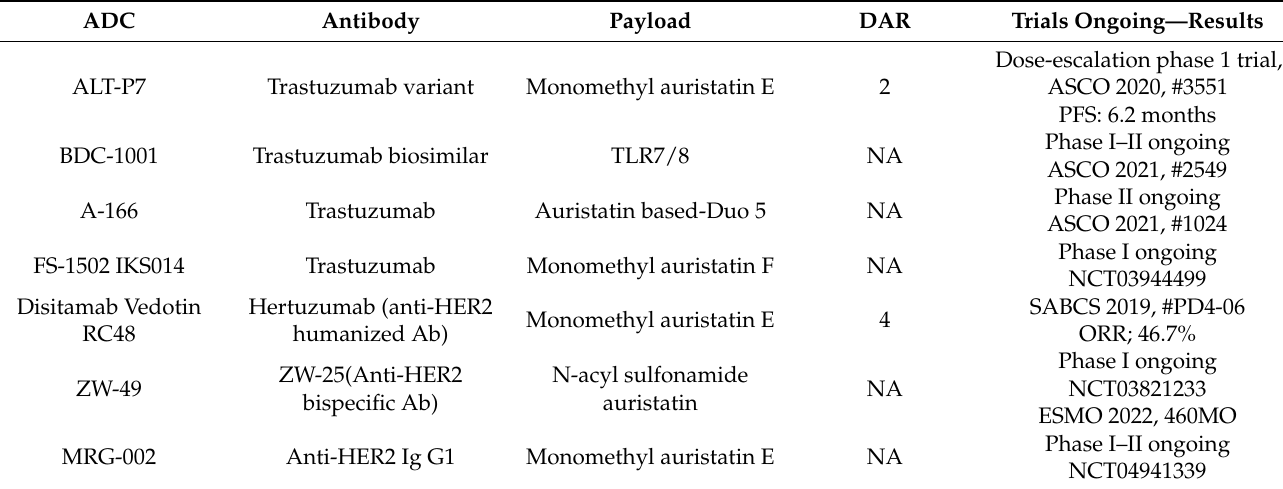
Table 1. Other HER2-targeted ADCs in clinical